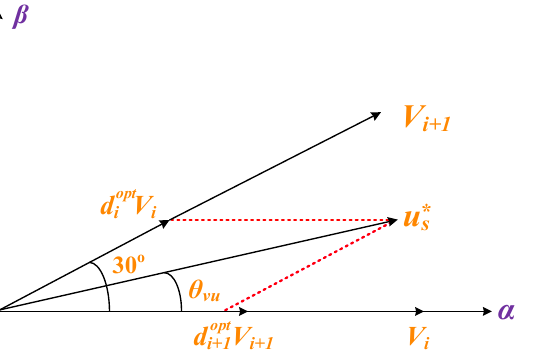
Figure 9. Diagrammatic sketch of three voltage vectors used to synthesize a reference vector.